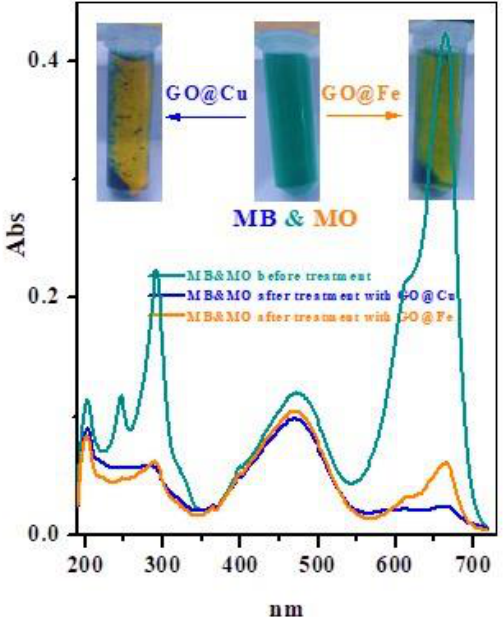
Figure 10. UV–vis spectra of (MB-MO) binary system solution before and after treated with GO@M (M = Cu 2+ or Fe 3+ ) composite. Inset: optical images that present the color of the MB-MO binary solution before and after being treated with GO@M.